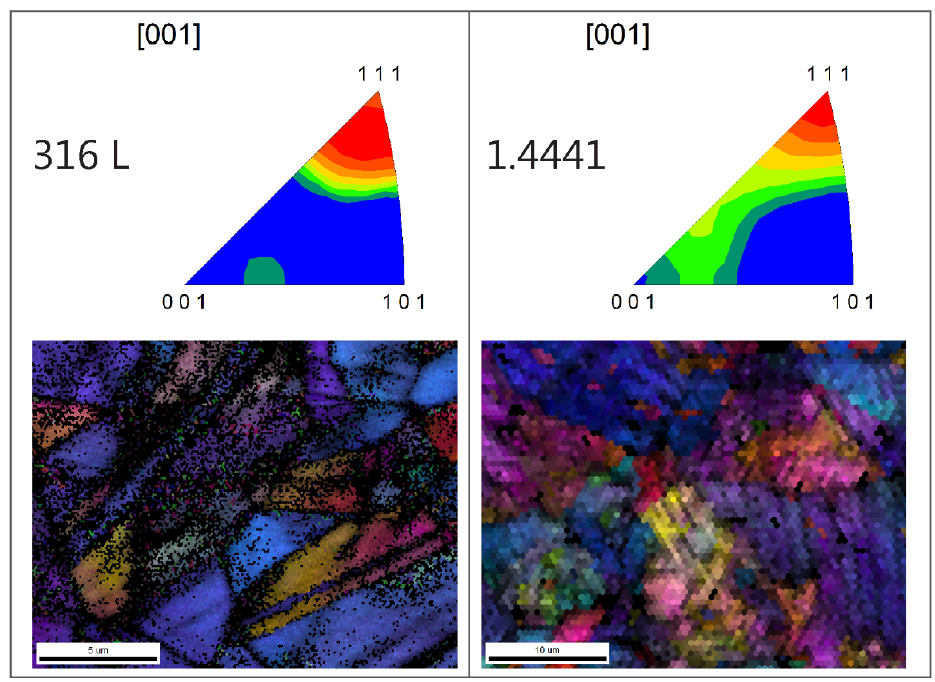
Figure 6. Plot (IPF) and EBSD measurement of the two stainless steel materials.